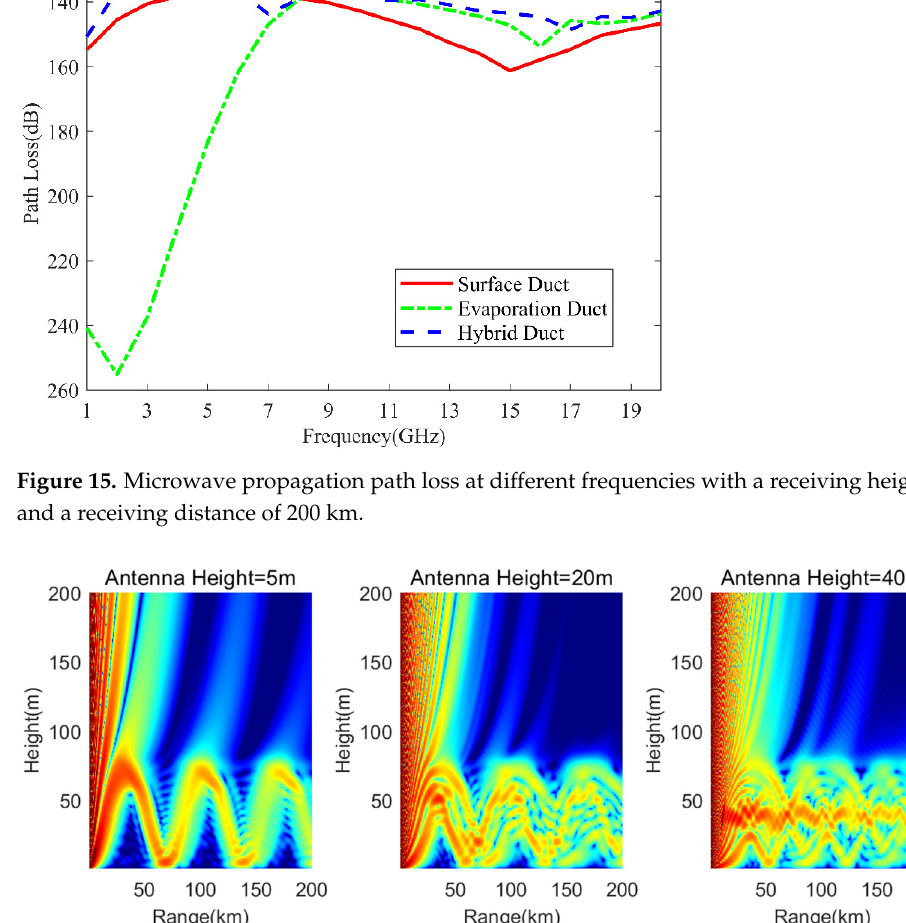
Figure 17. Path loss distributions for evaporation ducts with di ff erent antenna heights: ( a ) antenna height of 1 m, ( b ) antenna height of 20 m, and ( c ) antenna height of 40 m. ( a ) ( c ) Figure 18. Path loss distributions for hybrid ducts with di ff erent antenna heights: ( a ) antenna height of 1 m, ( b ) antenna height of 20 m, and ( c ) antenna height of 40 m. Figure 19 shows the path loss of electromagnetic waves with di ff erent antenna heights. When only evaporation ducts are considered, the path loss is small when the an- tenna height is low, and the path loss is the smallest when the antenna height is 5 m, at 139.3 dB. With increasing antenna height, microwaves do not transmit in the evaporation duct layer, and the path loss is large. When considering only surface ducts, the path loss decreases to 138.9 dB at an antenna height of 5 m, increases to 157.9 dB at an antenna